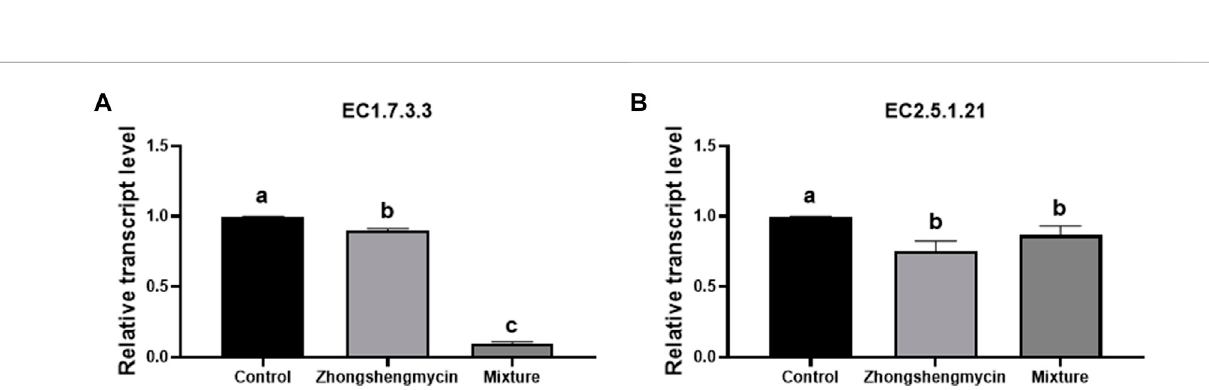
FIGURE 2 Age-speci fi c survival rate and fecundity of N. lugens (A) Age-speci fi c survival rate ( l x ) of N. lugens in different treatments; (B) age-speci fi c maternity ( l x m x ) of N. lugens in different treatments; (C) age-speci fi c fecundity of N. lugens in different treatments ( m x ); (D) female age-speci fi c fecundity ( f x ) of N. lugens in different treatments.